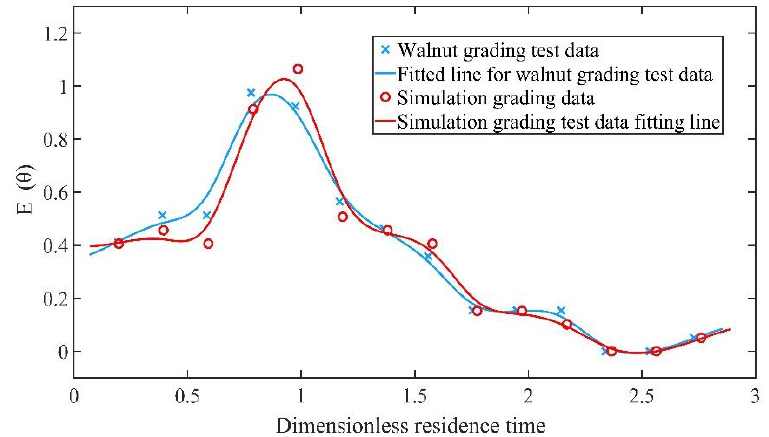
Figure 11. Comparison of the dimensionless staying time of walnuts